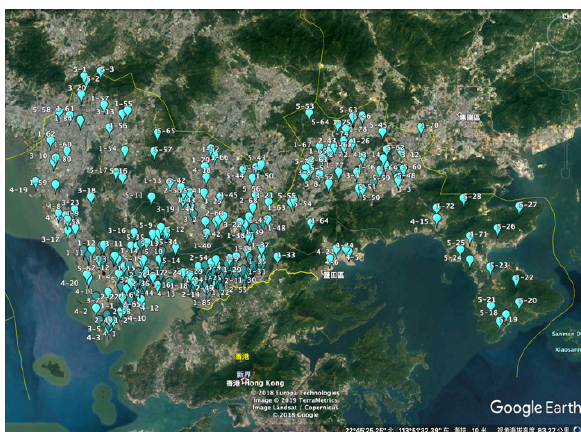
Figure 3. The placemarks manually interpreted based on Google earth